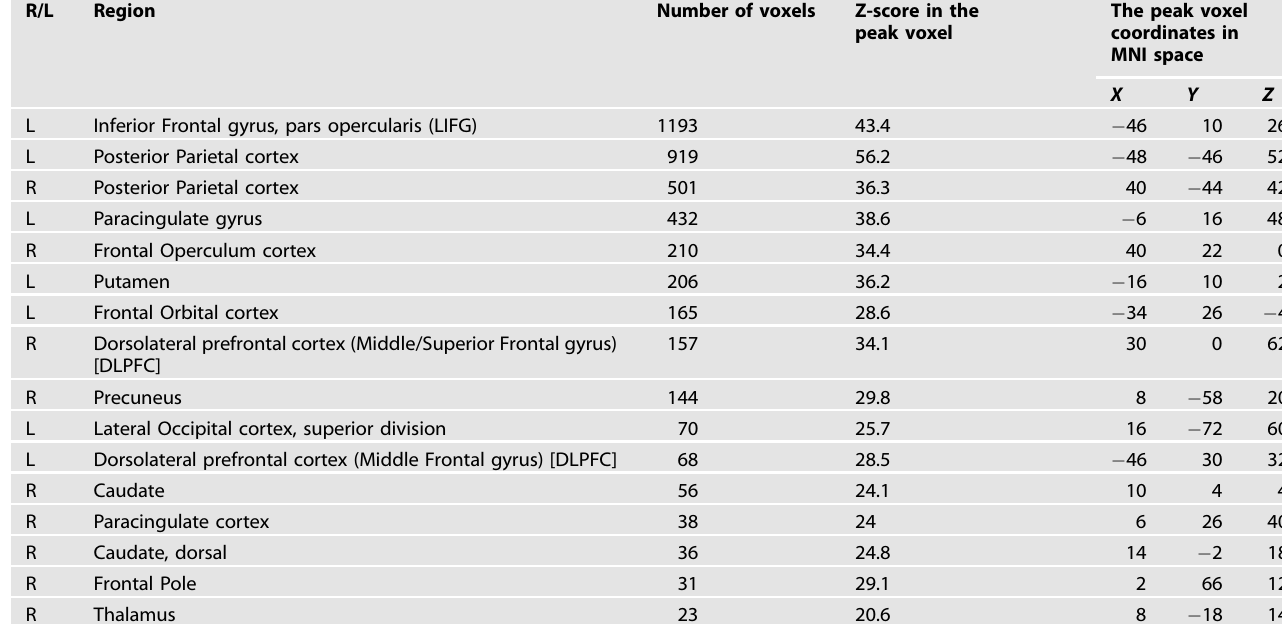
Table 3. Main effect of Group on 2-back vs. 0-back differences in brain